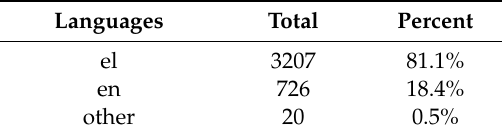
Table A23. Primary languages (gr).